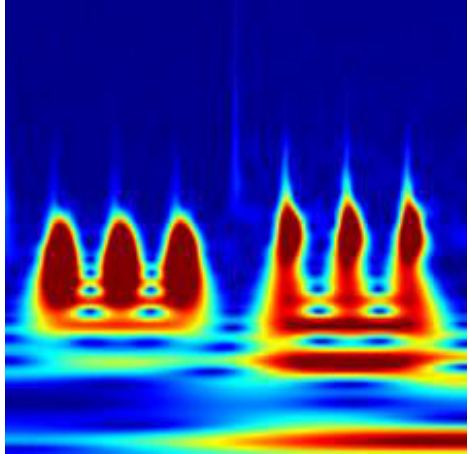
Figure 9. Time-frequency representation for the bias fault